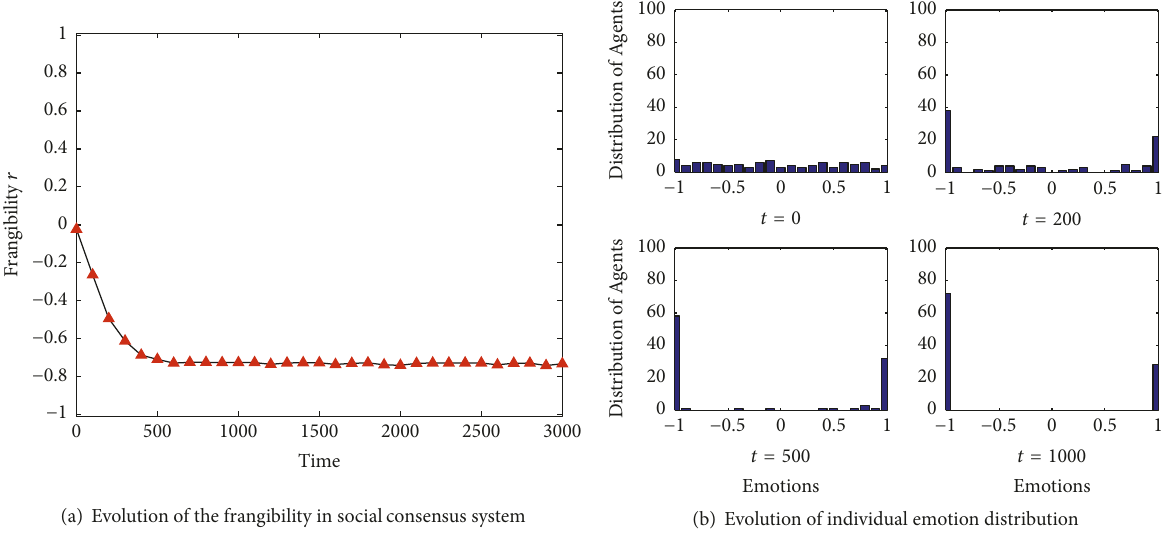
Figure 1: Evolution of social consensus system with low negative event